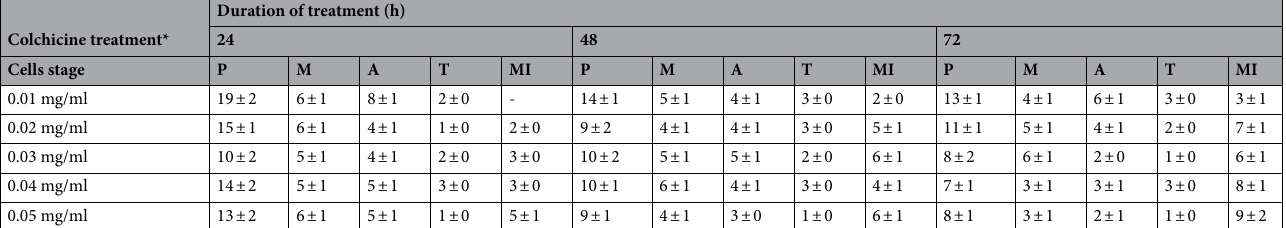
Table 3. Anti-mitotic activity of isolated colchicine (Iso 1) from elite germplasm of Gloriosa superba . P prophase, M metaphase, A anaphase, T telophase, MI mitotic inhibition. The mean value of number of cells was converted to whole number in case the mean value is in fraction. *Values are mean (n = 3) ± S.D.